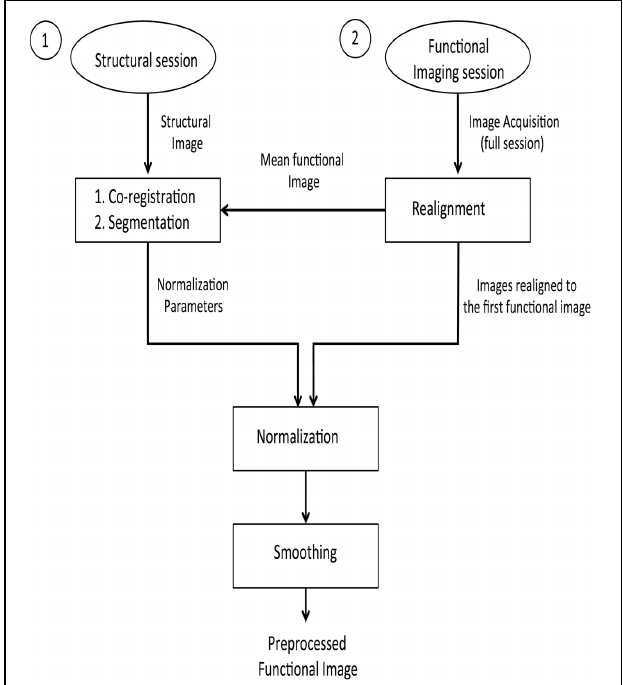
FIGURE 1 | Pre-processing steps on the structural and functional images for the offline subject-independent and dependent classifier. First, re-alignment of the functional images is performed by considering the first functional image as the template. Next, co-registration is performed using the structural image and the mean functional image which is, created after the realignment of functional images. Following the segmentation of the structural image, normalization of the functional images is performed using the normalized parameters calculated in the previous step. Finally, functional images are smoothed using a Gaussian